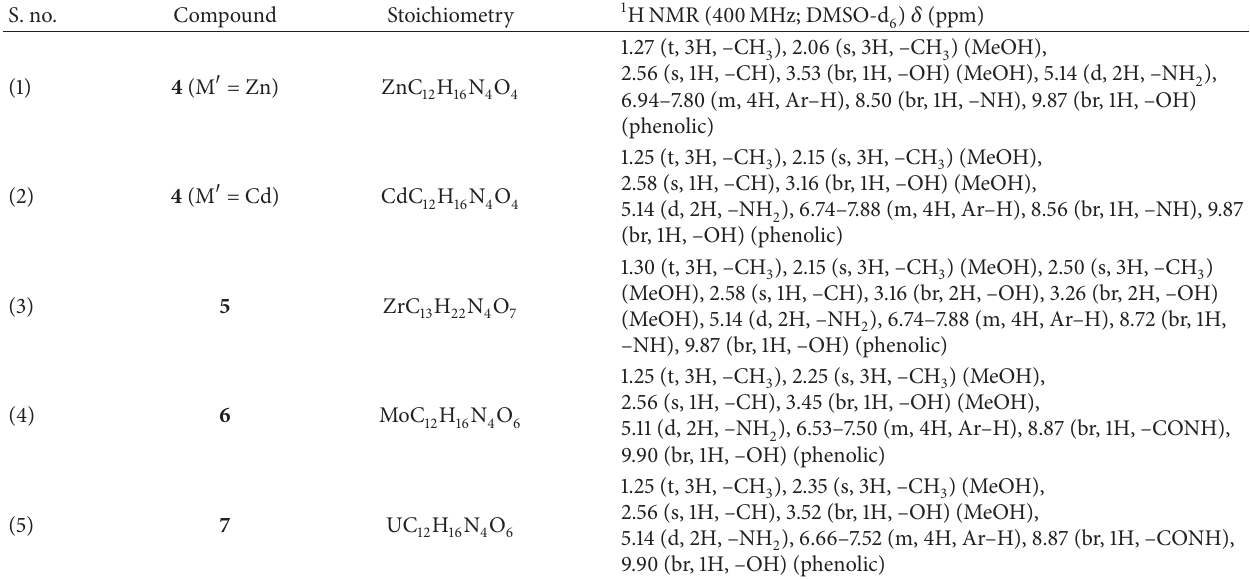
Table 3: NMR spectral data of the coordination